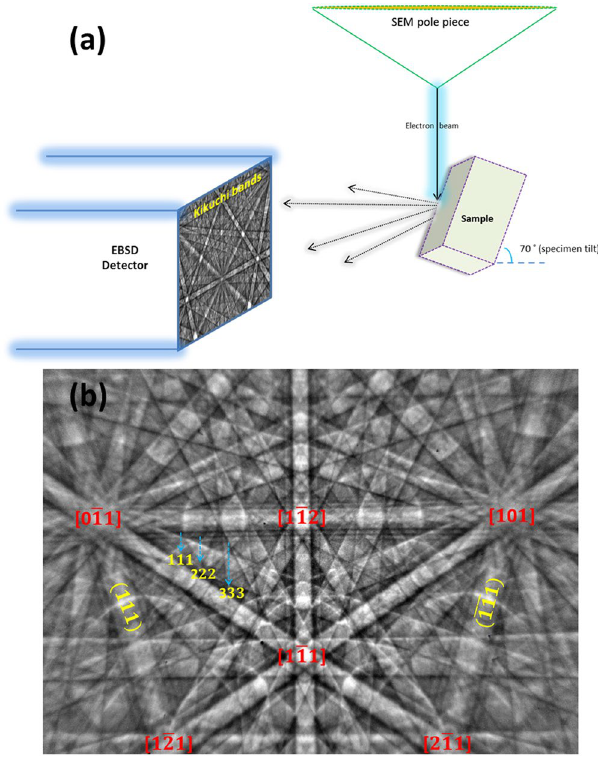
Figure 2. EBSD experimental setup. ( a ) Schematic of a standard EBSD detection geometry and (b ) EBSD pattern from a GaP thin film marked with some major lattice planes and well-visible zone